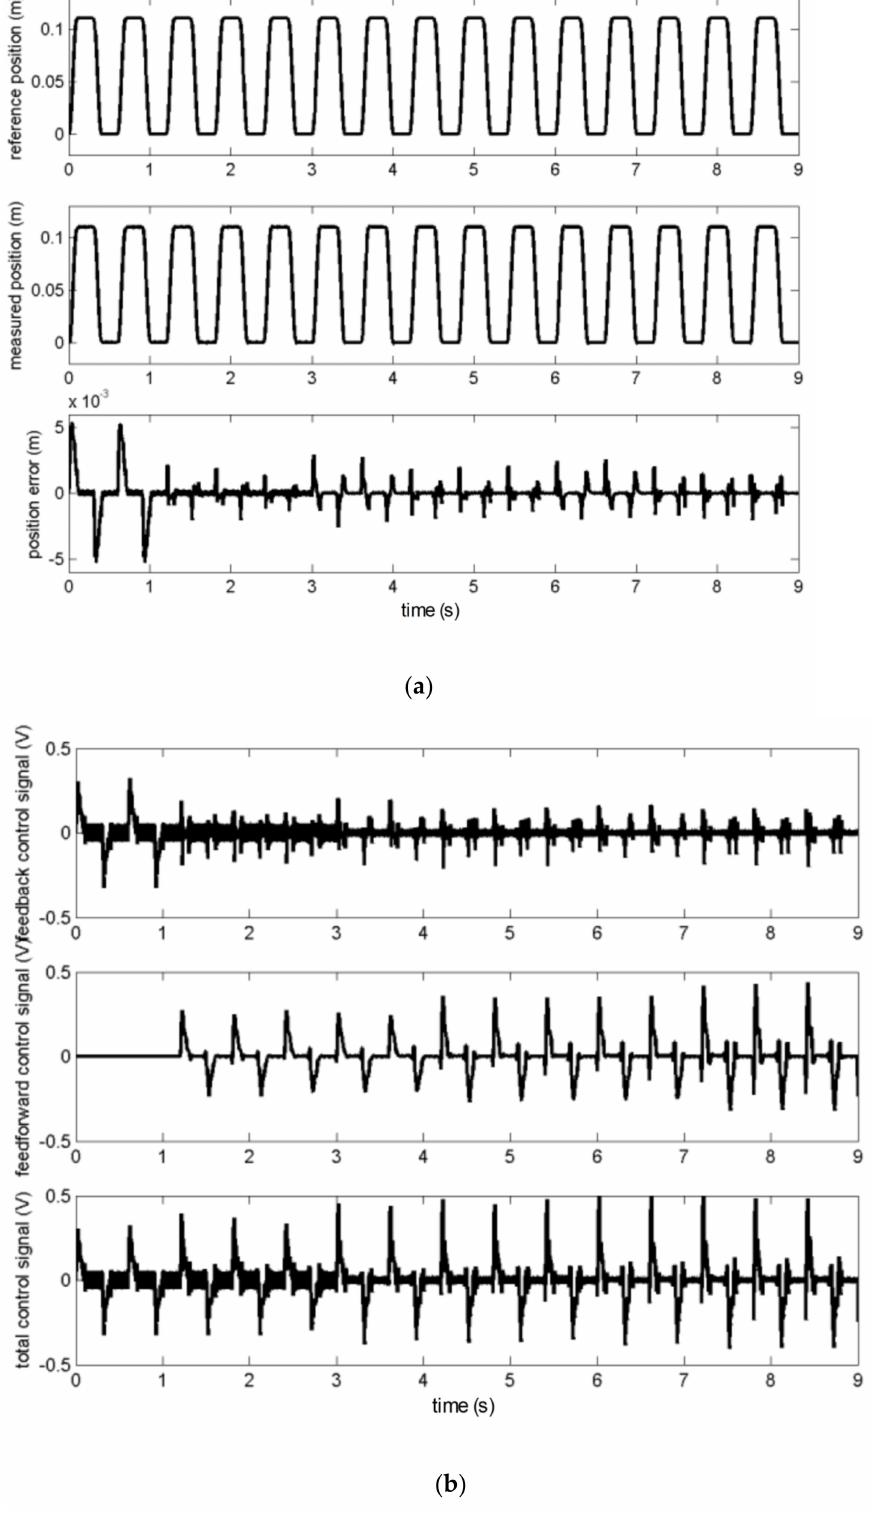
Figure 9. The second test with the effect of nonlinear cogging and friction force: ( a ) position error; ( b ) control